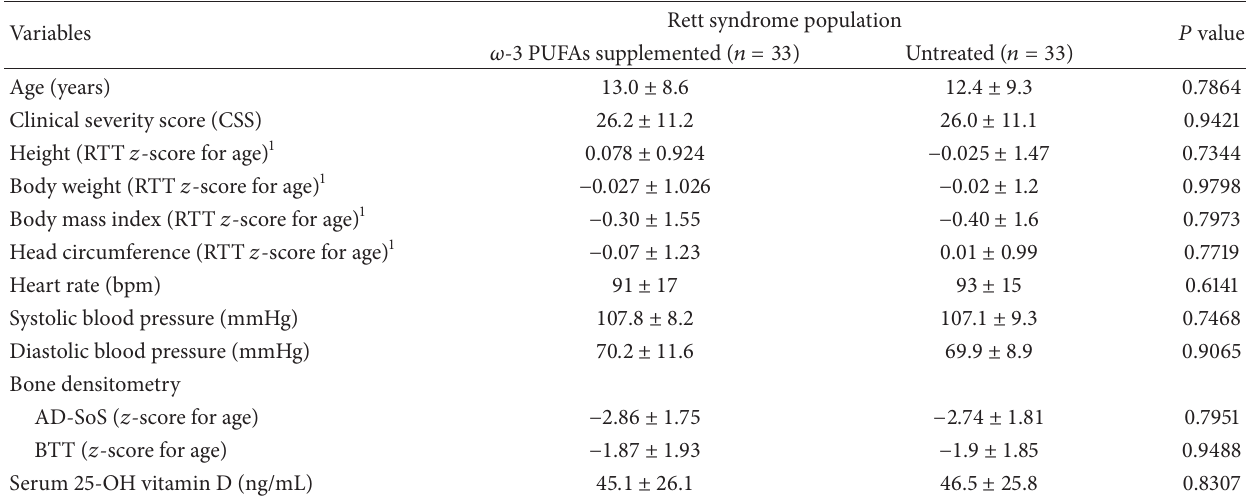
Table 1: Phenotypical severity, biometrics, bone densitometry estimates, and 25-hydroxy vitamin D serum levels were comparable between the 𝜔 -3 PUFAs-supplemented and the untreated Rett patients